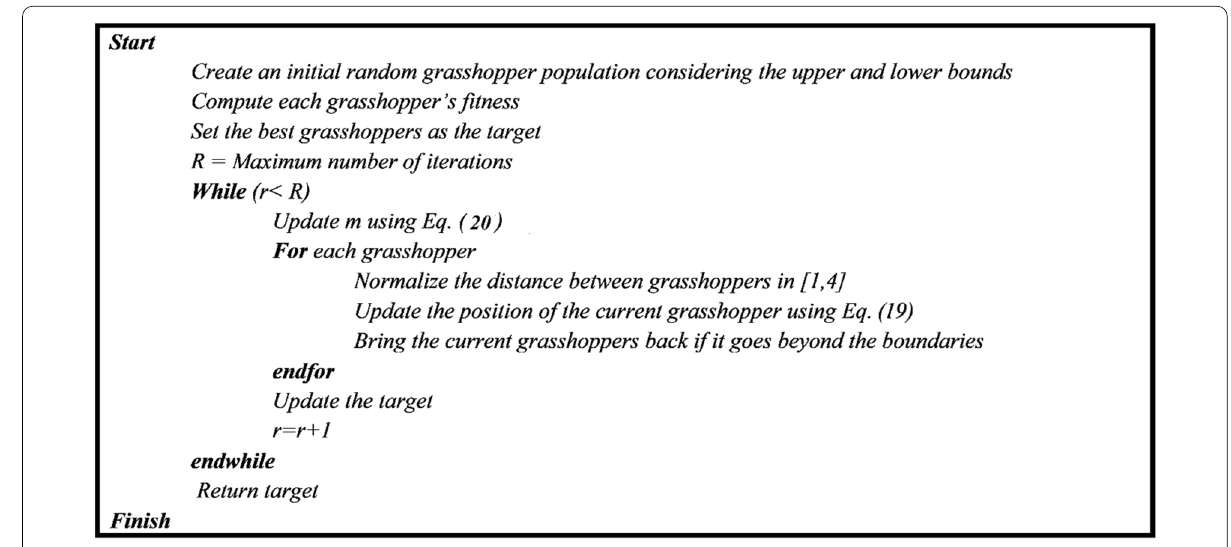
Fig. 9 Example of the pseudocode using GOA.